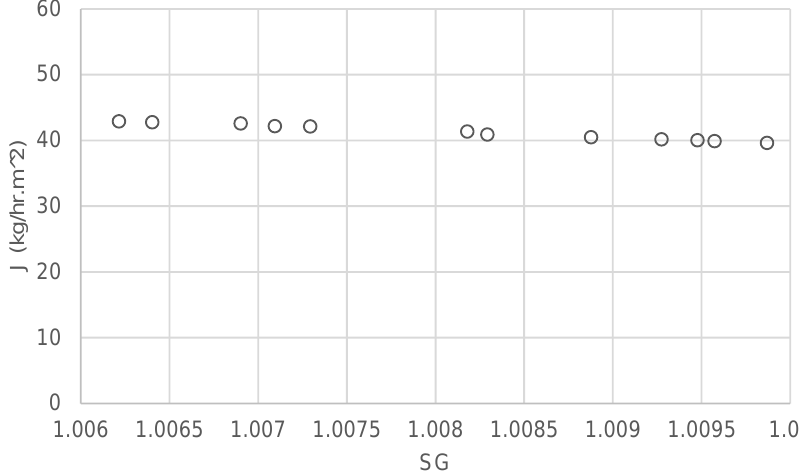
Figure 14. Influence of increasing concentration during freshwater production on flux (J).